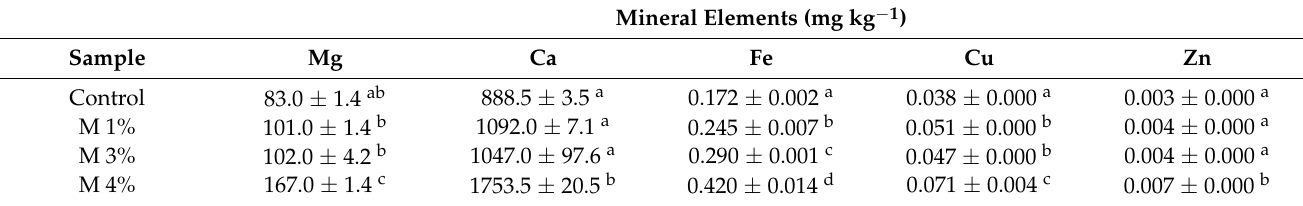
Table 8. Mineral elements in control sample (Control) and samples with moringa extract addition (1%, 3% and 4% of extract addition, M 1%, M 3%, M 4%) at the 1st day of analysis. Mineral Elements (mg kg − 1